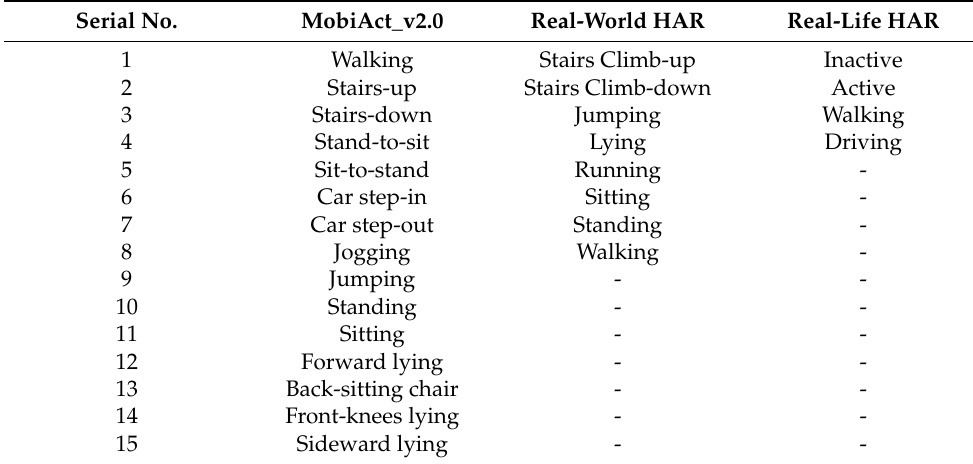
Table 2. Human locomotion activities provided by all three datasets. Serial